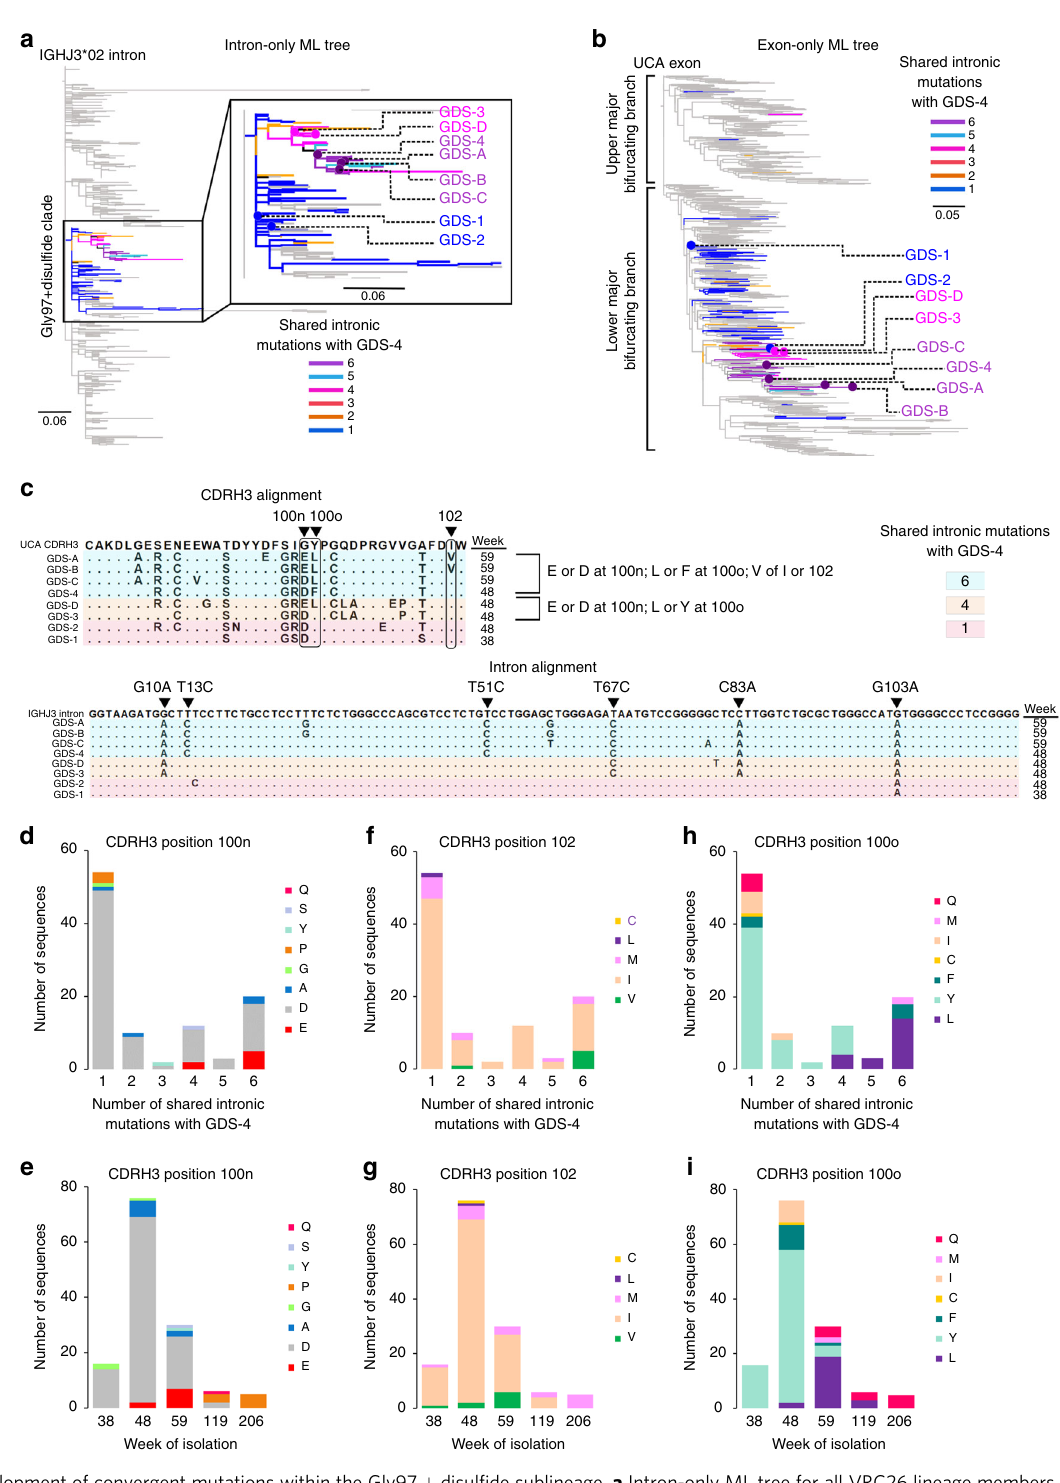
Fig. 3 Development of convergent mutations within the Gly97 + disul fi de sublineage. a Intron-only ML tree for all VRC26 lineage members. The Gly97 + disul fi de clade is highlighted by number of shared intronic mutations with GDS-4. Sequences labeled GDS-(1 – 4) were selected for expression. b The exon- only ML tree for all VRC26 members is shown with the location of the highlighted sequences in a indicated. c CDRH3 and intron alignment for the representative sequences marked in a and b . Three CDRH3 sites that eventually develop convergent mutations are circled and longitudinal time points of isolation are also indicated. GDS-4 intronic mutations are labeled and sequences are colored by the number of these mutations that they possess. d Number of Gly97 + disul fi de clade sequences that share intronic mutations with GDS-4 and their amino acid composition at CDRH3 Kabat position 100n. e Same as in d except shown by longitudinal time point of isolation. f Same as d except shown for CDRH3 position 102. g Same as in e except for CDRH3 position 102. h Same as in d except for CDRH3 position 100o. i Same as in e except for CDRH3 position